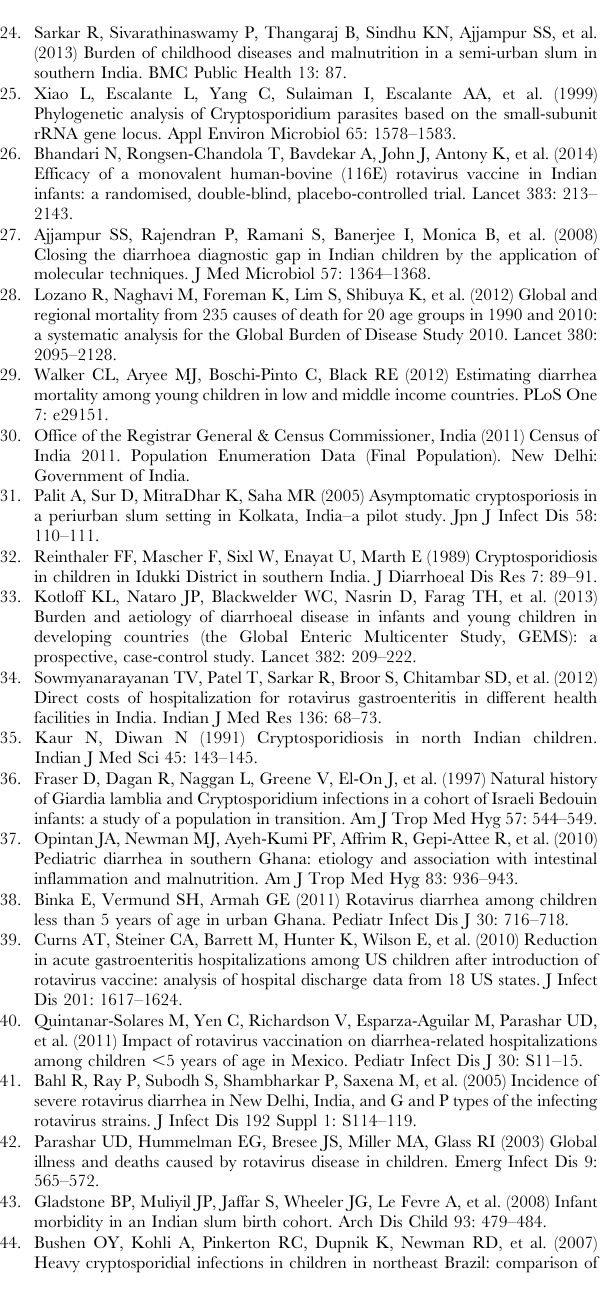
Table S1 Calculation of the correction factors to adjust for the state-to-state variation in the prevalence of diarrhea and access to health-care due to diarrhea in Indian